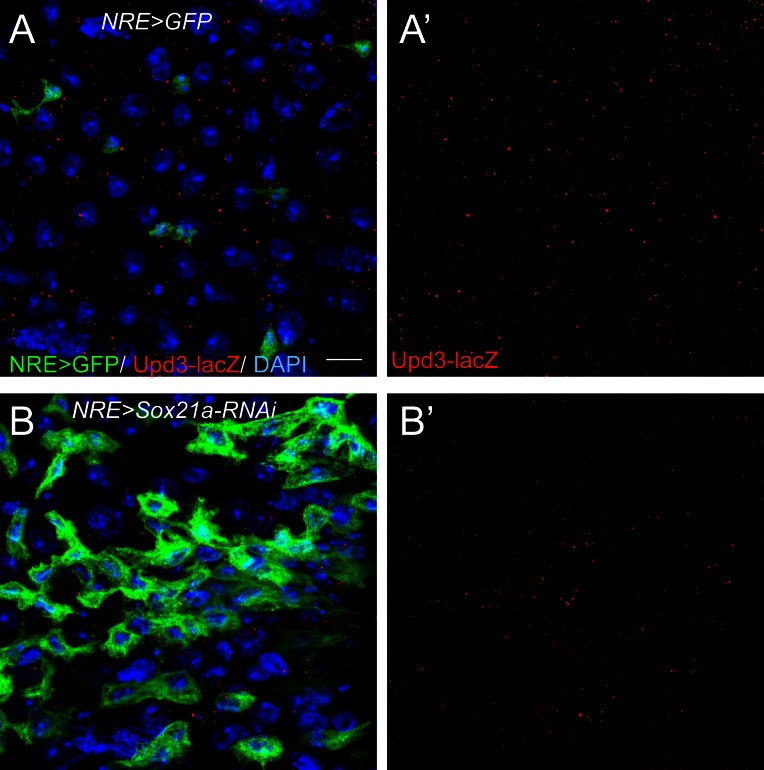
Upd3-lacZ was not significantly upregulated in Sox21a-depleted EBs.(A) Staining of Upd3-lacZ (red) in midgut of NRE-Gal4; UAS-GFP (green). (B) Staining of Upd3-lacZ (red) in midgut of NRE-Gal4; UAS-GFP; UAS-Sox21a RNAi. GFP was in green. Upd3-lacZ was not obviously upregulated in Sox21a-depleted EBs. Weak upregulation of Upd3-lacZ was sometimes observed in the nearby GFP- cells. Scale bars: 10 μmDOI: